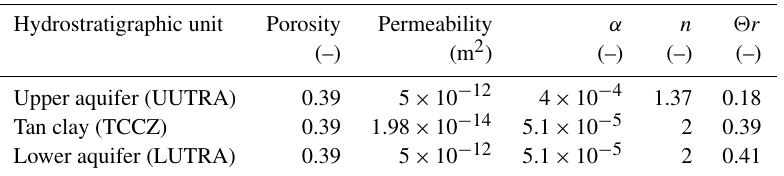
Figure 1. (a) Location of seepage basins in the F-Area of the Savannah River site (SRS). (b) Hydrostratigraphic units defined for the F-Area; (c) 2D cross-section model domain. Modified from Bea et al. (2013). Table 1. Physical model parameters used in the simulations. α , n , and (cid:50)r are the parameters of inverse air entry suction, a measure of the pore-size distribution, and residual water content, respectively, in the van Genuchten water retention